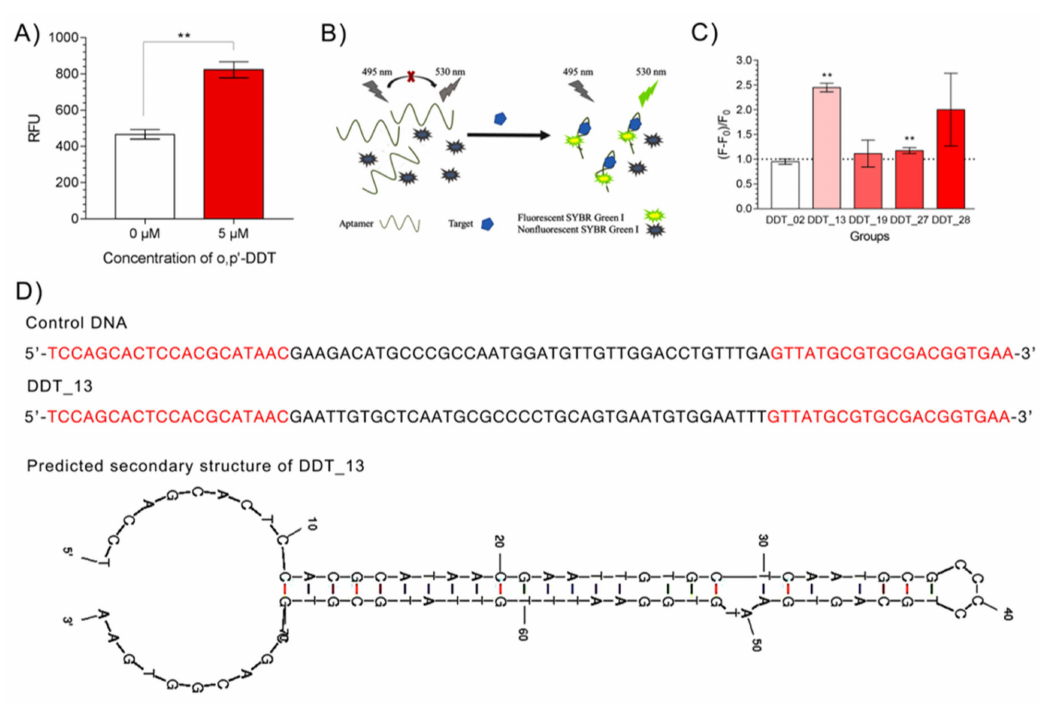
Figure 2. Characterization and analysis of the last round library and the candidate aptamers. ( A ) The fluorescence intensity of the library in round 13 against o,p’ -DDT. ( B ) The principle of SYBR Green I (SGI) assay. ( C ) Fluorescence responses of five candidate sequences by SYBR Green I (SGI) assay. ( D ) Comparison of DDT_13 and control sequence. Full sequence of the control DNA and the o,p’ -DDT candidate aptamer, DDT_13 were presented. The red letters are primer binding sites. Secondary structure of DDT_13 was predicted by Mfold software. ** means p value < 0.01, when compared with that of the binding bu ff er